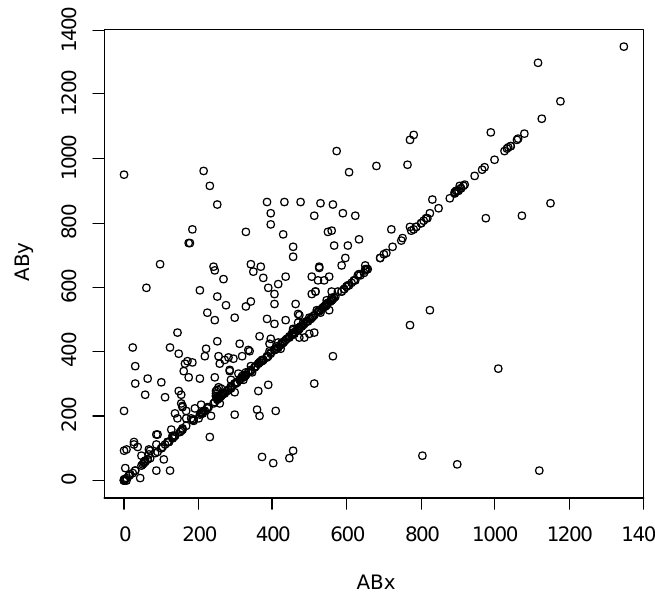
Figure 1. TTF recorded for pairs of Components A and B